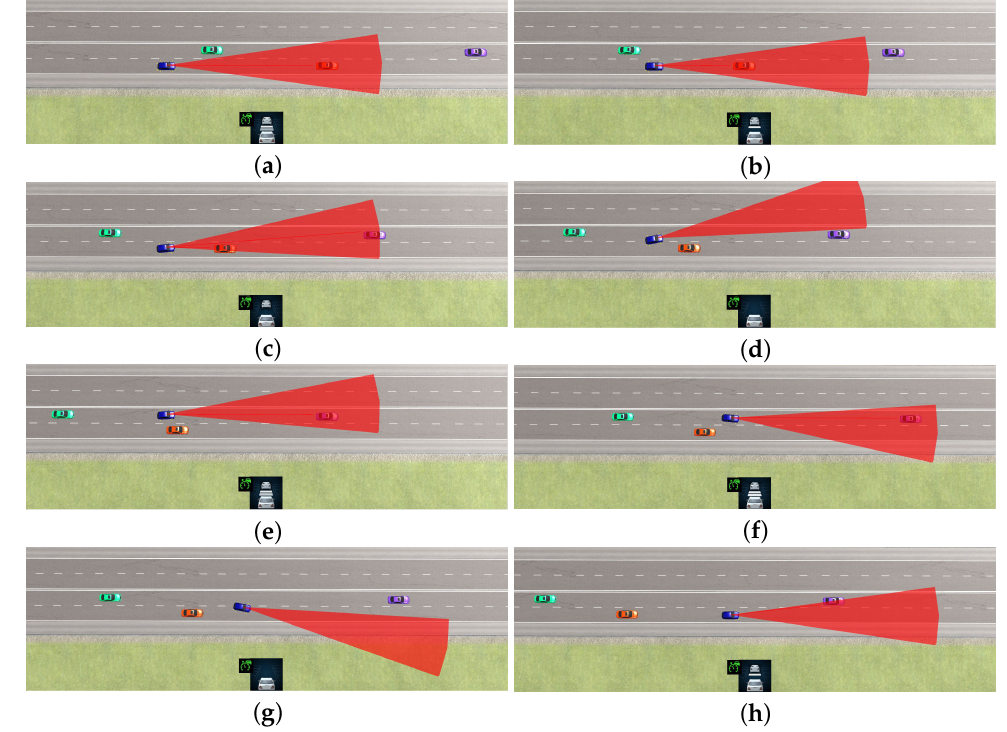
Figure 6. Simulation animation screenshot of Scenario